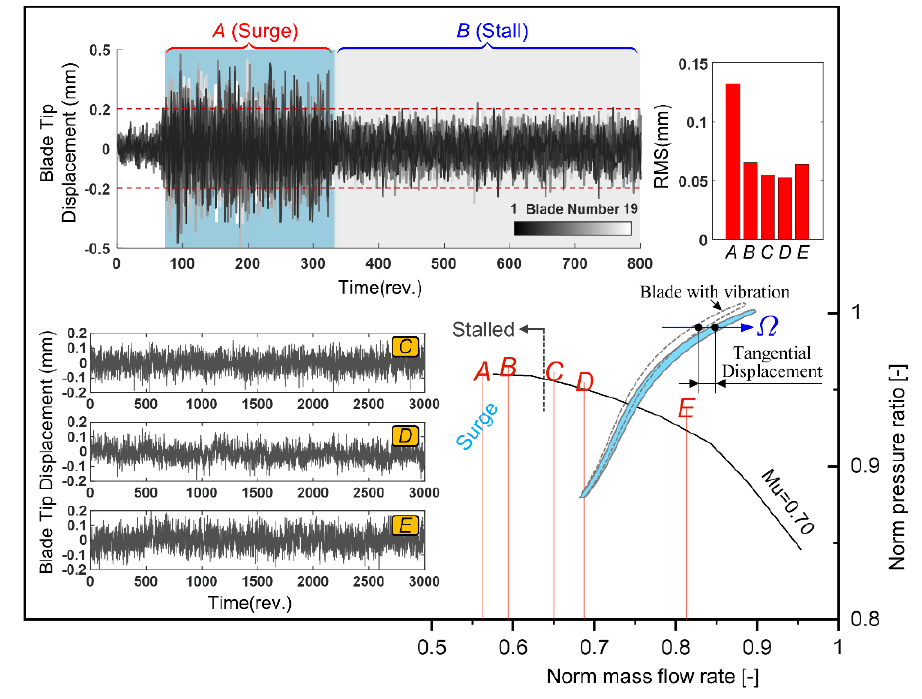
Figure 12. Blade tip timing results under five operating points with di ff erent mass flow rate varying from surge to